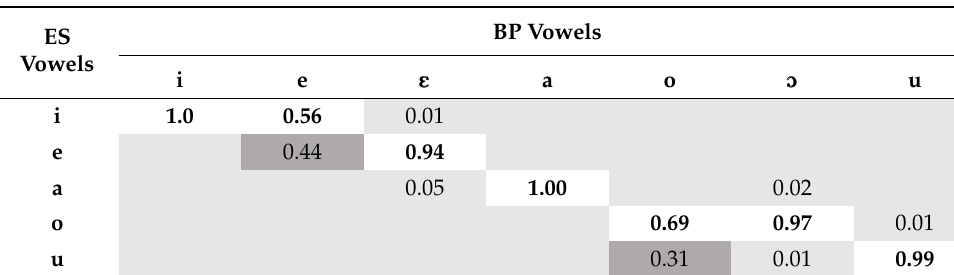
Table 5. European Spanish listeners’ classification percentages. The native vowel category with the highest classification percentage appears in bold, classification percentages above chance appear in cells shaded dark grey and classification percentages below chance (i.e., 0.20) appear in cells shaded light